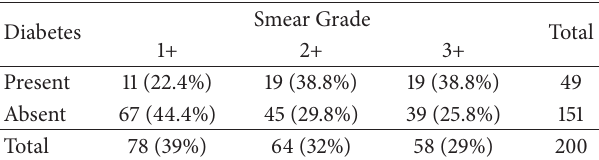
Figure 7: Age and gender distribution of the study population. The majority of the patients are of the age group between 41 and 50 with male preponderance. Table 2: Relationship between diabetes mellitus and sputum smear grade. Higher smear grades were observed in patients who were diabetic. ( 𝑃 value: